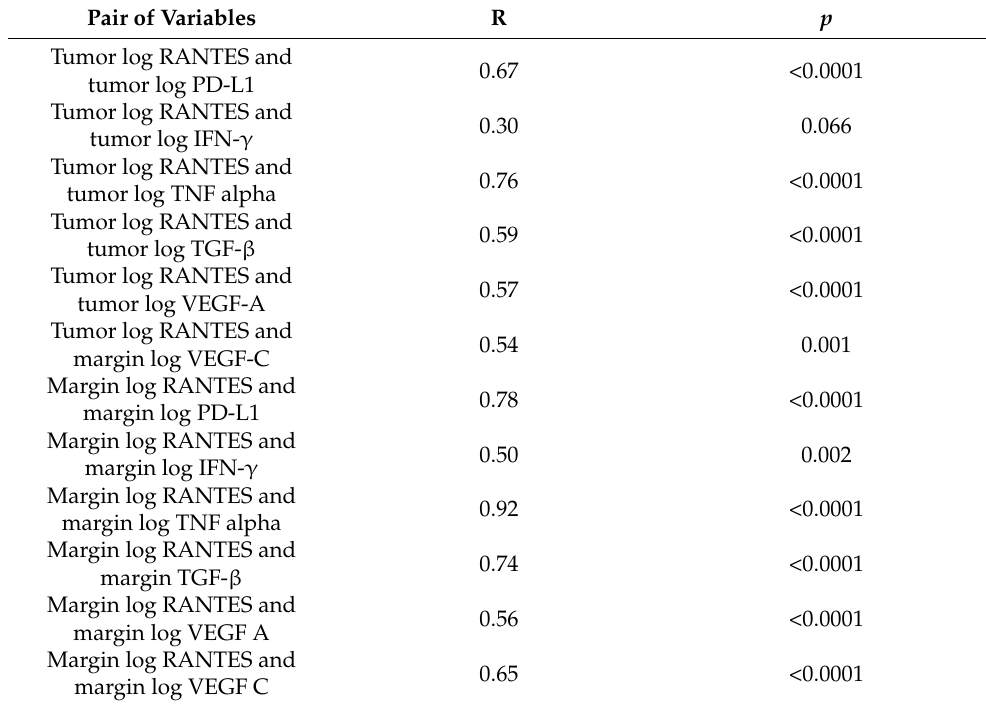
Table 4. Correlations between the RANTES levels and the examined molecules. R—Pearson’s correlation coefficient.